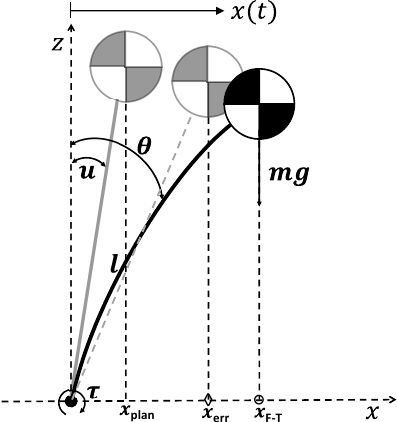
Figure 11. Single inverted pendulum model including the robot’s flexibility